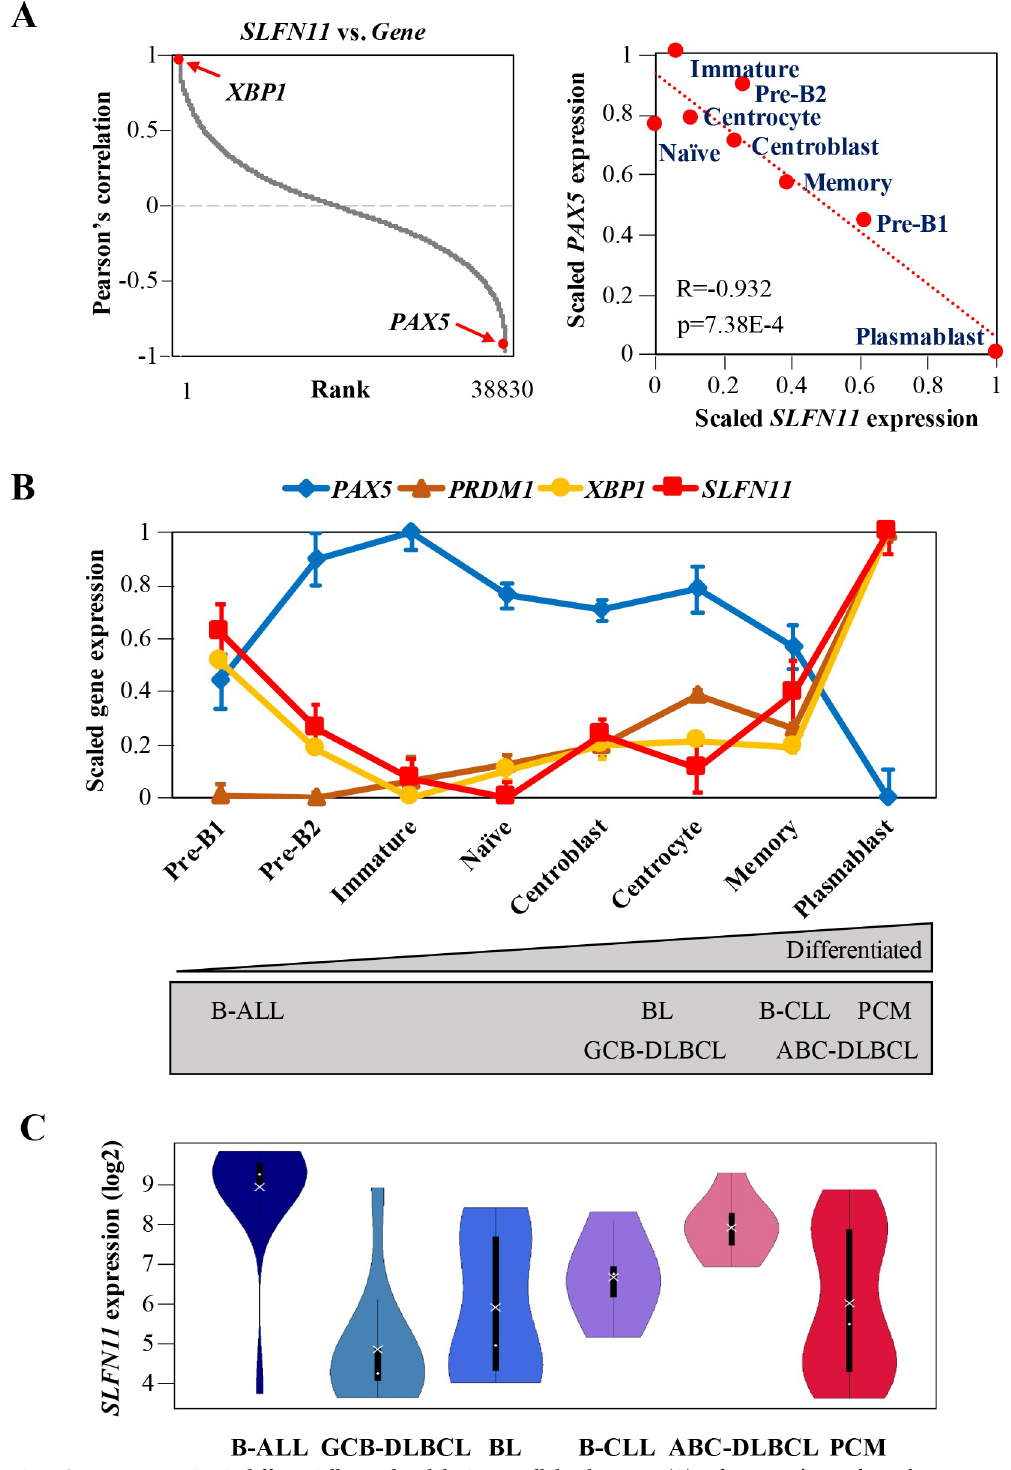
Fig 1. SLFN11 expression is differentially regulated during B-cell development. (A) Left: Pearson’s correlation between SLFN11 and all the other genes. The genes are ordered from the highest correlation (left) to the lowest correlation (right). Right: microarray gene expression plot of SLFN11 and PAX5 . Precursor (Pre)-B1 cells, precursor (Pre)-B2 and immature B- cells are were taken from human bone marrow (n = 5), and na ï ve B-cells, centroblasts, centrocytes, memory B-cells and plasmablasts were taken from human tonsil (n = 6). Pearson’s correlation (R), P-value (p) and regression line (red dotted